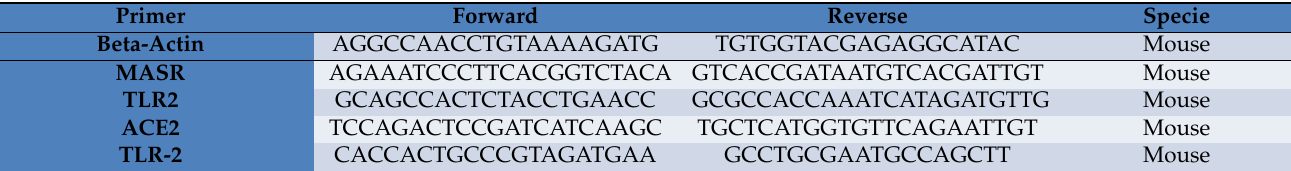
Table 1. Gene sequence forward and reverse (Beta actin, MasR, TLR-2, ACE2,